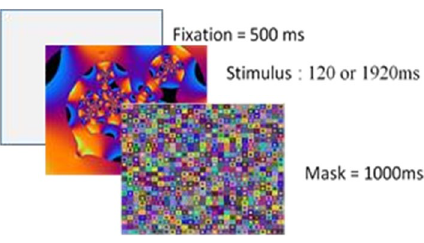
Figure 5. Sequence of a trial during the learning phase. Each trial started by a 500-ms cross fixation, followed by an image, then by a 1000-ms complex mask. The images came from the CerCo lab’s collection of